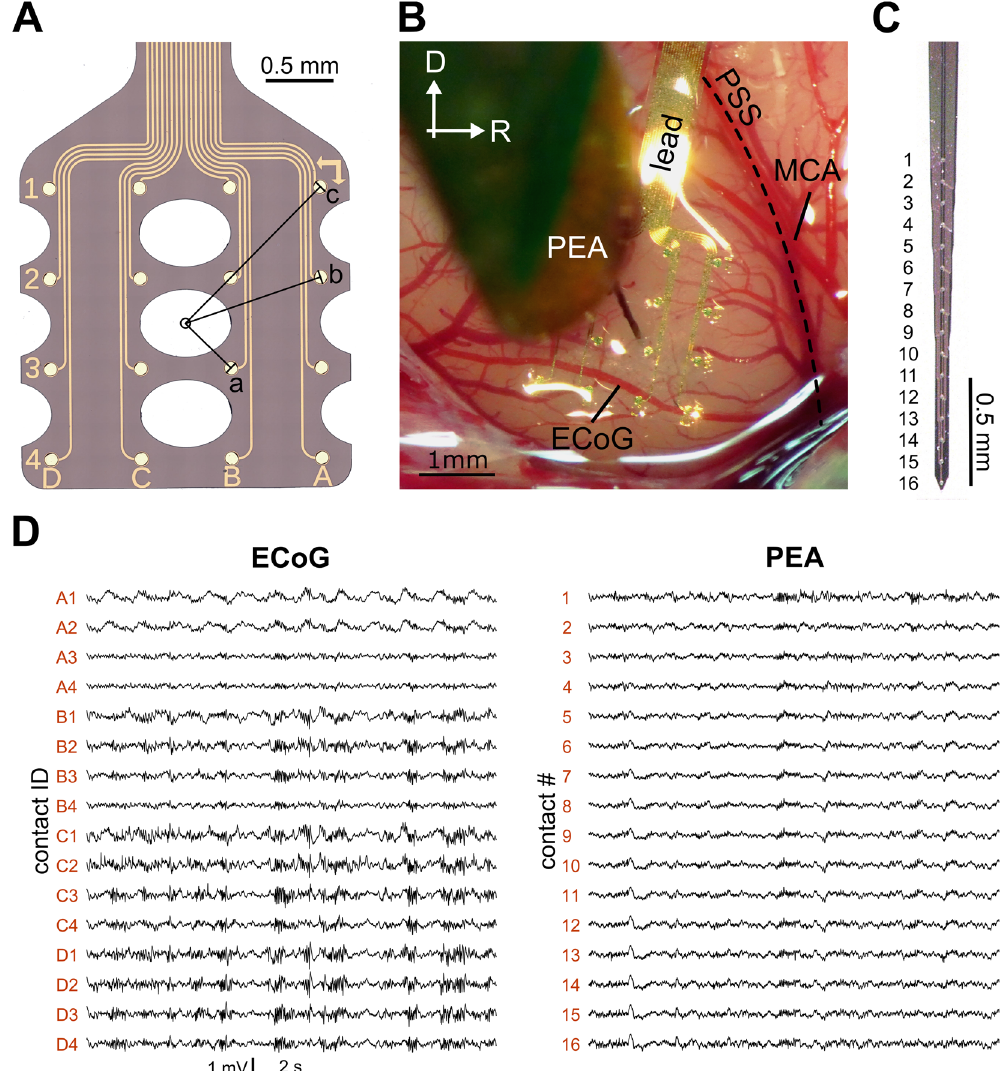
Figure 1. Recordings from the newly developed ECoG grid were possible for all 16 surface contacts and were similar to simultaneous recordings from a conventional penetrating multi-electrode array. ( A ) Sketch of the subdural ECoG grid. Markers on the grid facilitate the allocation to the respective surface locations. The distances to the central insertion point are indicated (a = 0.5 mm, b = 1.0 mm, c = 1.3 mm) ( B ) The penetrating multi-electrode array (PEA) is inserted through an opening in the ECoG grid substrate. Marked are the pseudo sylvian sulcus (PSS) and the middle cerebral artery (MCA), which served as landmarks for spatial alignment of different recording positions. ( C ) Example image of a 16 channel single shank PEA. ( D ) Examples of traces (raw signal) for an ECoG grid and a penetrating multi-electrode array from the same cortical recording during spontaneous